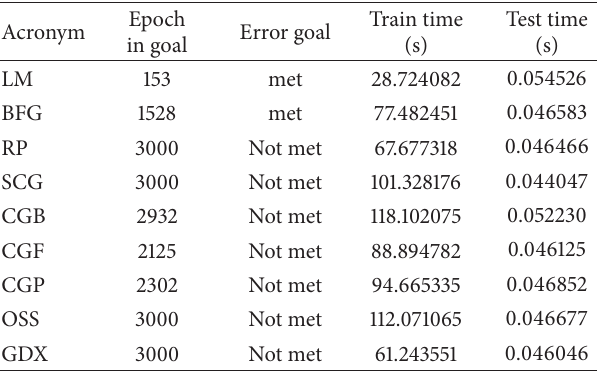
Table 6: The results of the variable training methods in the BPN with newelm function.